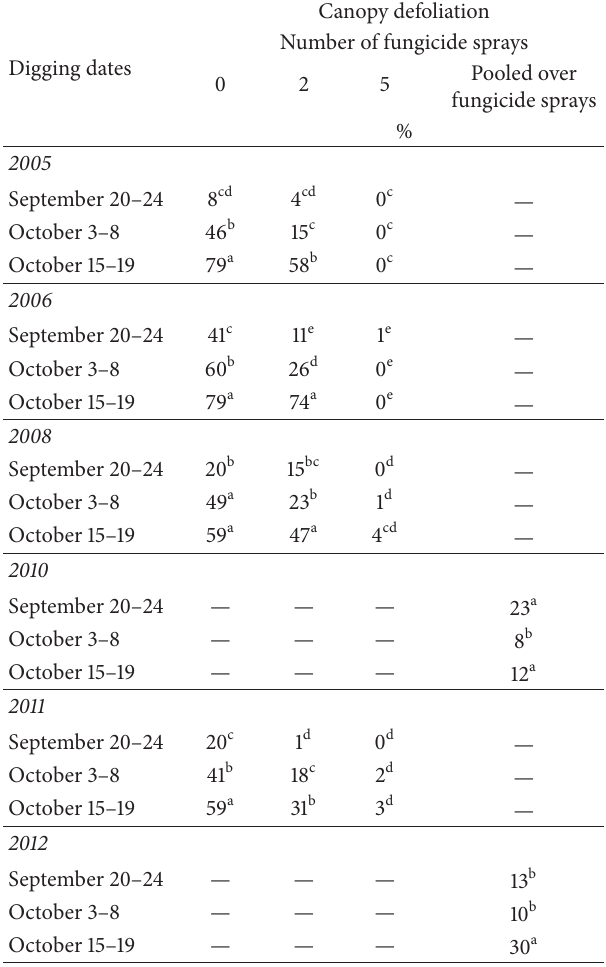
Table 8: Canopy defoliation as influenced main effects of digging date and fungicide regime and the interaction of year, digging date, and fungicide regime ∗ .